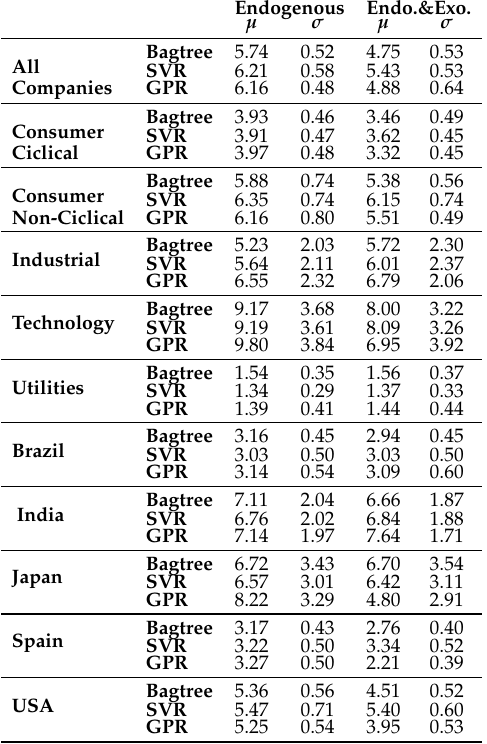
Table 3. Statistical analysis of one-hundred realizations of the best performing models, for different input-space subset scenarios. In rows, industries and region subsets. In columns, mean ( µ ) and STD ( σ ) of RMSE, for the scenarios including (i) endogenous variables, and (ii) both endogenous and exogenous